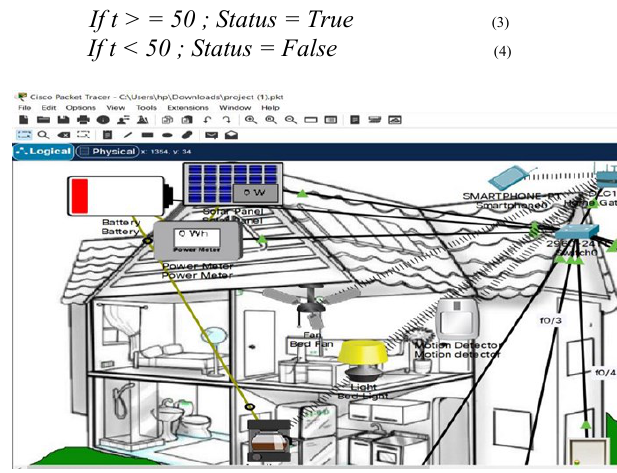
Fig. 6. Above shows the connection for the solar panel SOLAR PANEL: This solar panel sensor detects the battery present in the solar panel and turns the coffee machine on and off accordingly. The conditions upon which the solar panel sensor will operate are as follows - • If the available battery power (  in the solar panel is greater than 60% then the coffee machine will be turned